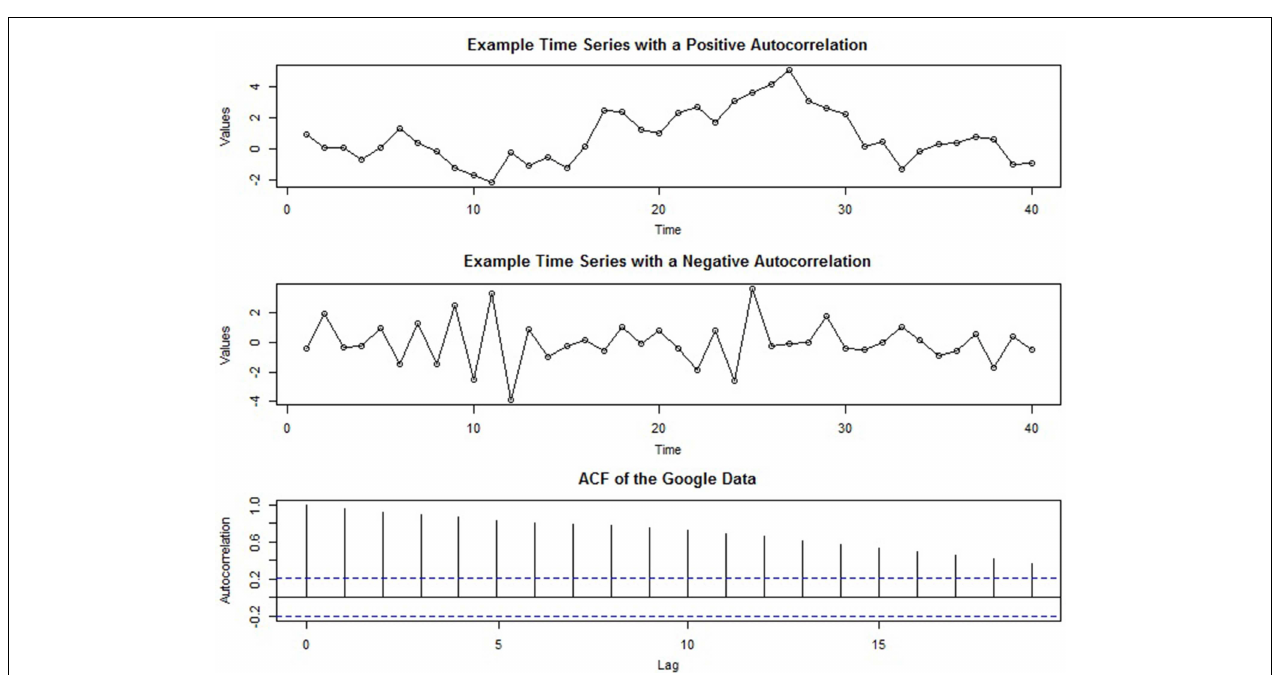
FIGURE 3 | Two example time series displaying exaggerated positive (top panel) and negative (center panel) autocorrelation. The bottom panel depicts the ACF of the Google job search time series after seasonal adjustment.